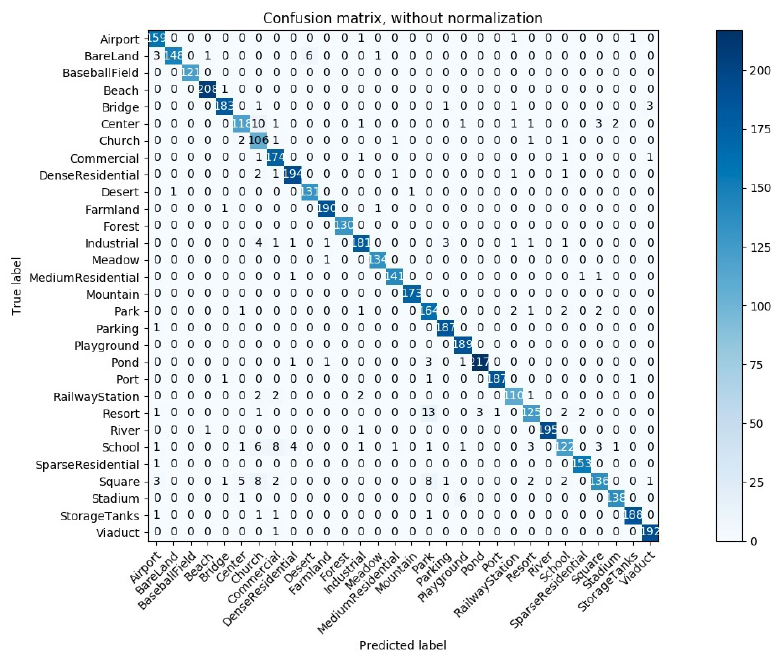
Figure 9. Confusion matrix of the proposed method with a 50%/50% train/test ratio of AID data set for ResNet50, linear learning rate decay, and softmax classifier.